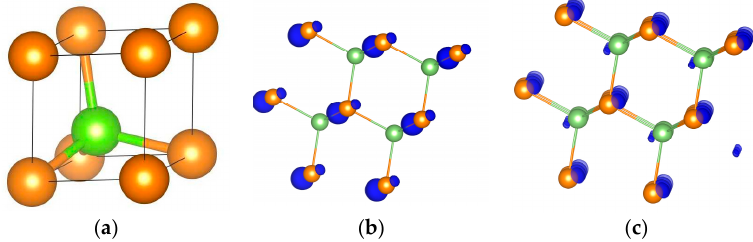
Figure 1. The primitive cell ( a ), and the valence ( b ) and the conduction ( c ) orbital densities of GaAs. The green and the yellow balls are the Ga and As atoms, correspondingly.